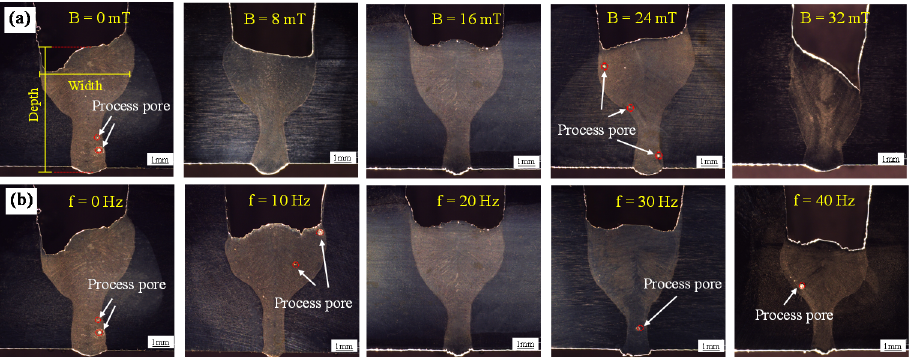
Figure 13. The appearance of weld cross-section under different magnetic intensity and frequency: ( a ) at 20 Hz with different magnetic intensity and ( b ) at 16 mT with different magnetic frequency.